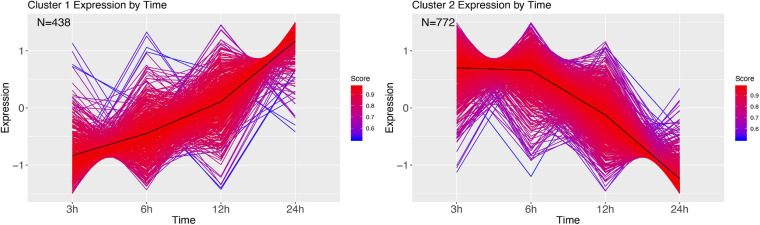
DEG clusters during M. luteus infection over 24 h. Color indicates cluster membership score, ranging from 0 (blue) to 1 (red).